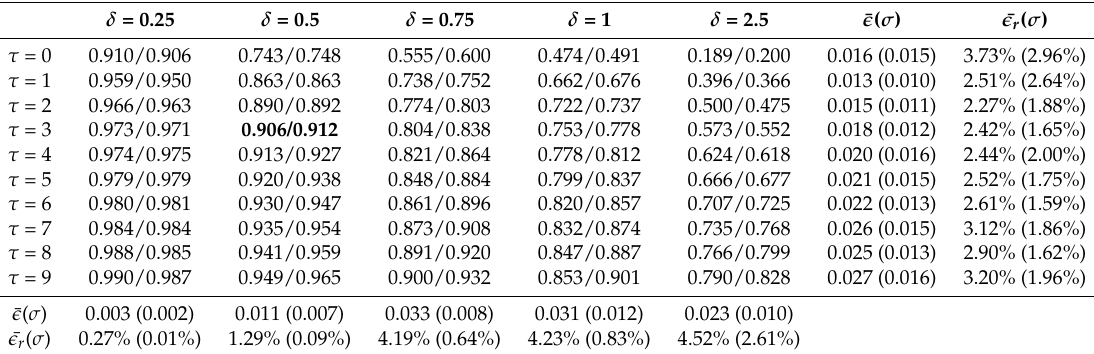
Table 3. Case study I. Transition Precision